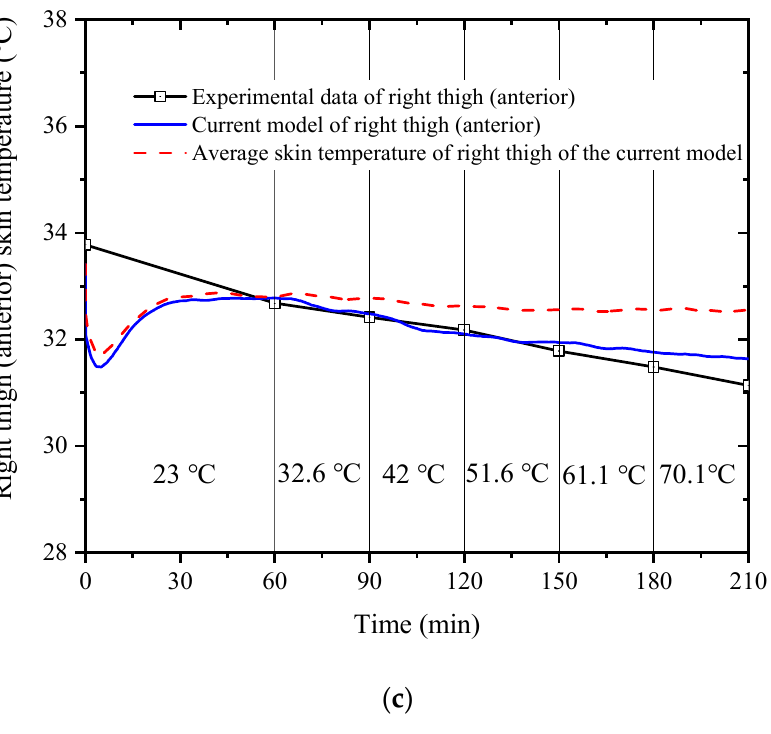
Figure 5. Comparison of the left arm (exterior) skin temperature ( a ), right arm (exterior) skin temperature, ( b ) and right thigh (anterior) skin temperature ( c ) between the experimental data [38] and the simulated results calculated with the current model.